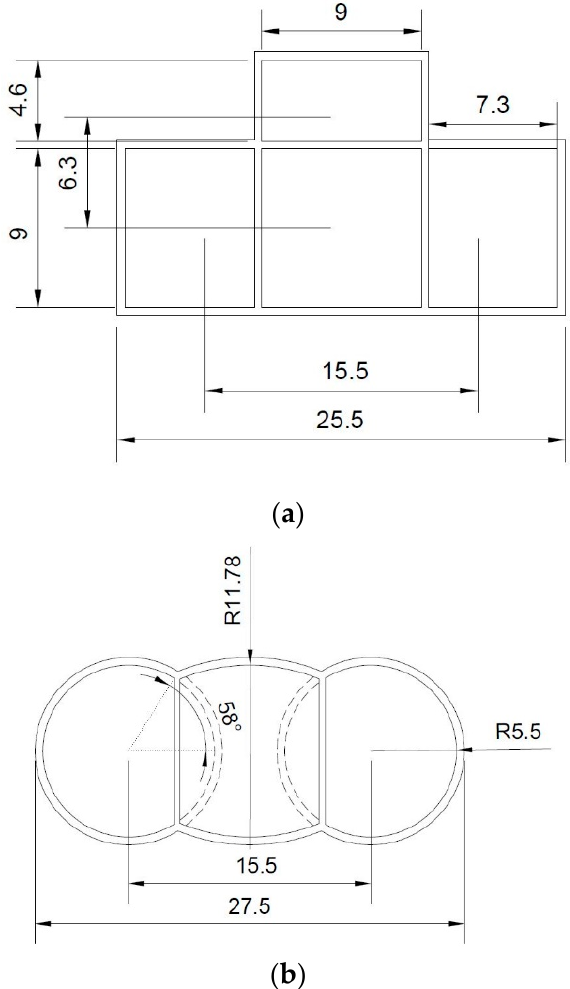
Figure 8. ( a , b ) Tunnel complex with dimensions: ( a ) Rectangular. ( b ) Equivalent horizontal twin, also showing the truncated parts (units in ‘m’).